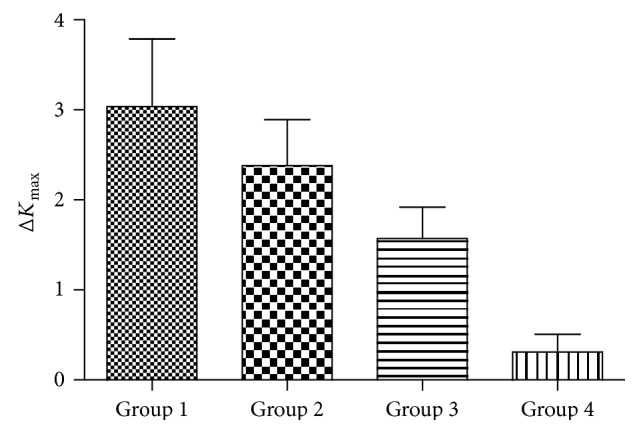
Comparison of ΔKmax between four groups after 1 year of treatment.